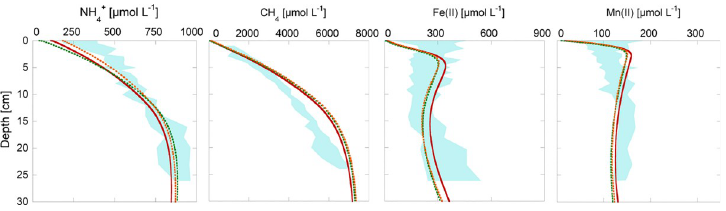
Fig 2. All measured porewater concentrations for the years 2014 and 2015 and modeled porewater concentrations of 2015. The blue shaded area indicates the seasonal porewater variations encountered in the field campaign. The red line is the modeled porewater concentration using average input parameters. The dotted lines represent seasonal modeled concentrations during the middle of the year (mid-June, orange) and the end of the year (mid-December,